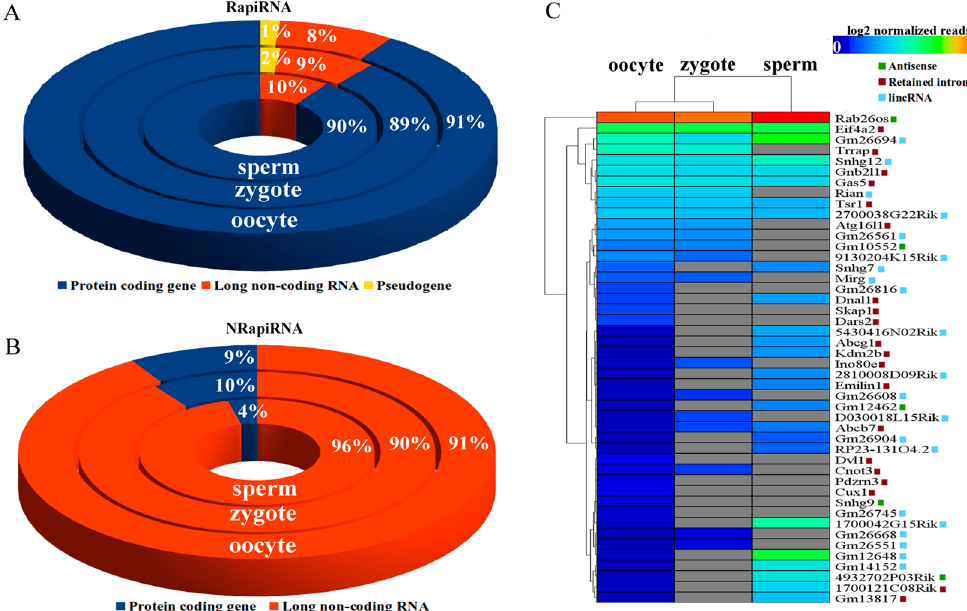
Figure 5. Annotation and classification of piRNAs mapping in introns. Circular diagrams show the piRNA read distribution associated with the intron of protein-coding genes, lncRNAs and pseudogenes. ( A ) RapiRNAs and ( B ) NRapiRNAs. ( C ) Hierarchical clustering of the intron mapping NRapiRNAs derived from lncRNAs. Annotation and lncRNA classification were based on the Ensembl database.